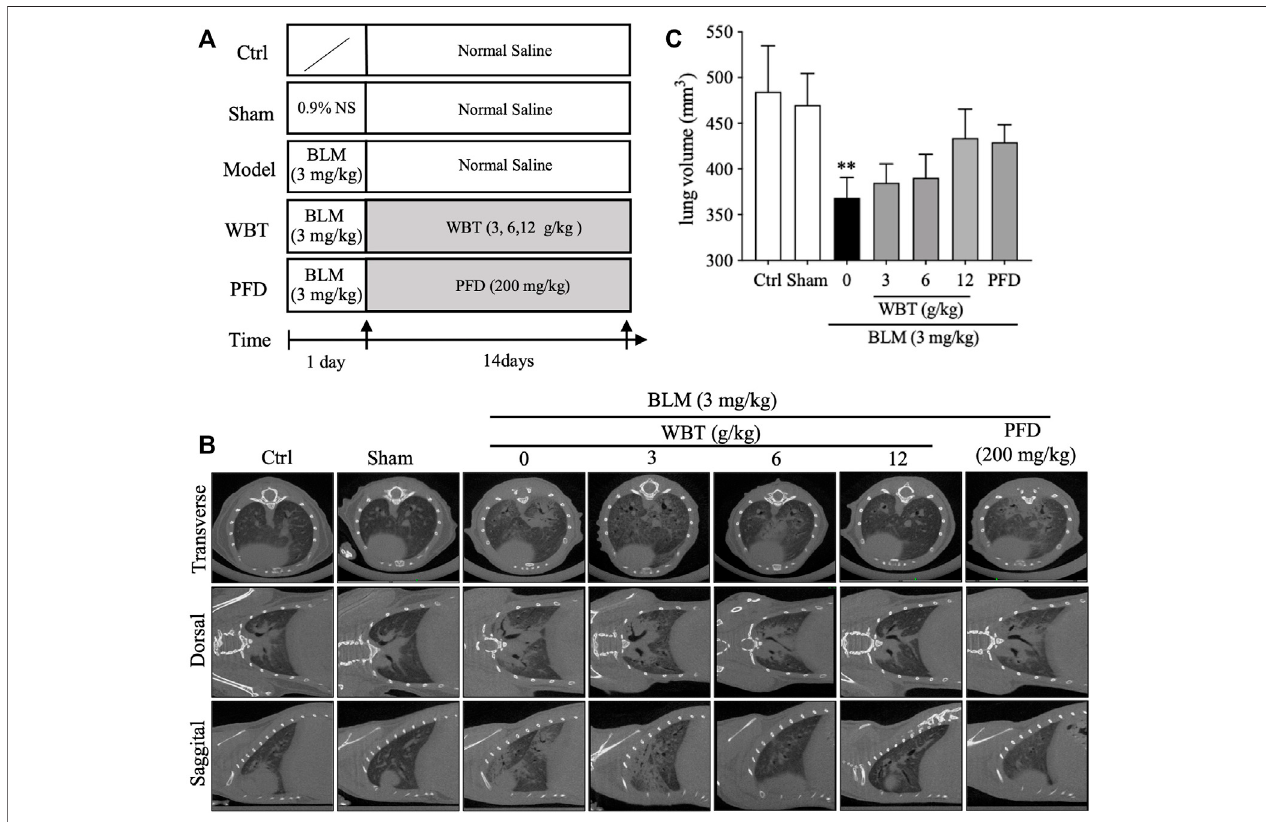
FIGURE 4| The protective effect ofWBT formula on BLM-induced lung injury was evaluated by micro-CTimaging. (A) A diagram for the mouse modeling process and WBT or PFD administration is shown. (B) After BLM induction and 14-day intervention, the representative in vivo micro-CT scans forthe lungs from different groups of Ctrl, Sham, BLM, BLM + WBT (3, 6, and 12 g/kg), and BLM + PFD (200 mg/kg) in the transverse, dorsal, or sagittal planes. (C) The lung volume ofdifferent groups in the BLM-induced mouse model was quanti fi ed by the three-dimensional volume rendering technique (n (cid:1) 4 per group). ** p < 0.01, compared to the Sham group. BLM, bleomycin; Ctrl, control; WBT, Wenfei Buqi Tongluo formula; PFD, pirfenidone.